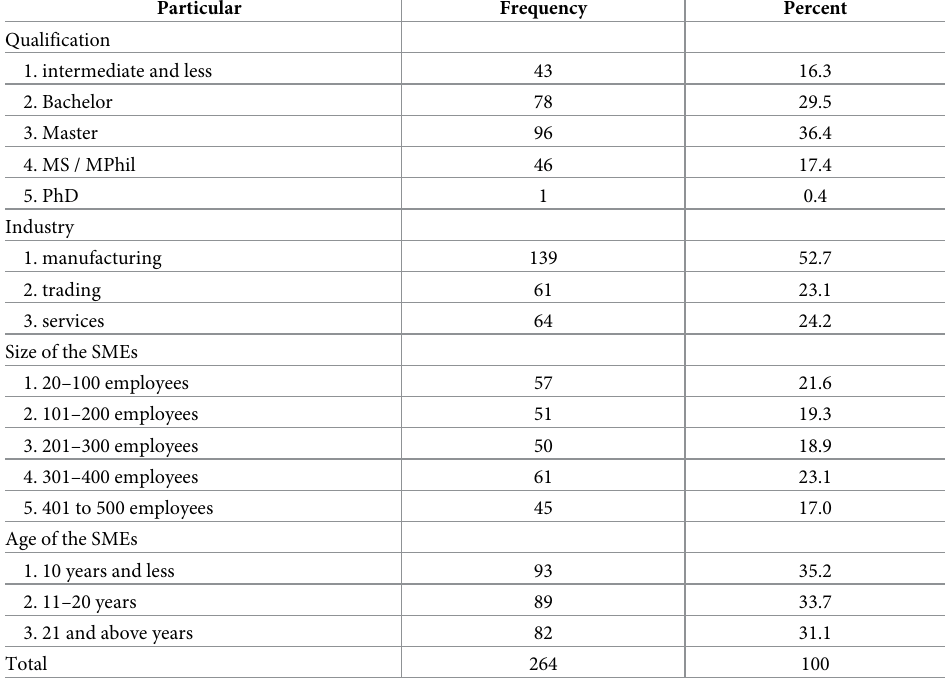
Table 1. Background of the